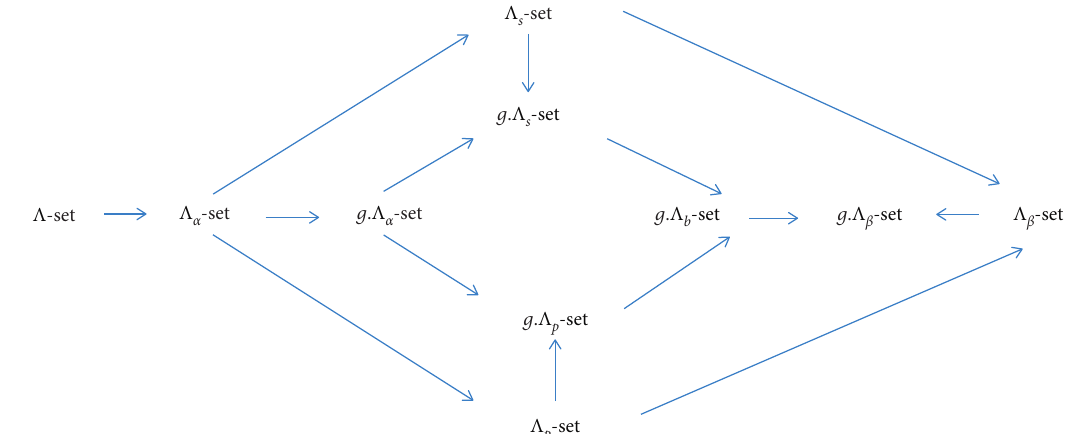
Figure 2: Relationship between some types of Λ -generalized closed